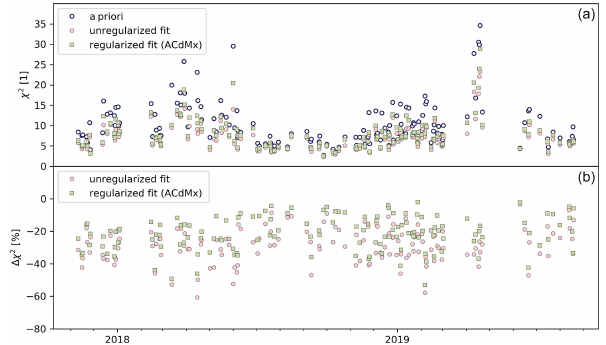
Figure 6. (a) The goodness of the fit ( χ 2 ) of the TROPOMI CO measurements and the simulation of the WRF-CHEM model for single-orbit overpasses. We distinguish the cases, only fitting background parameters (a priori) and additionally fitting the 10 tracer fields (unregularized and regularized). (b) Improvement of the goodness of the fit ( χ 2 ) when fitting the 10 tracer fields (un- regularized and regularized) relative to the (a priori) case. For the regularized fit we only show the χ 2 of the urban district ACdMx because it provides good data coverage when filtering for the de- gree of